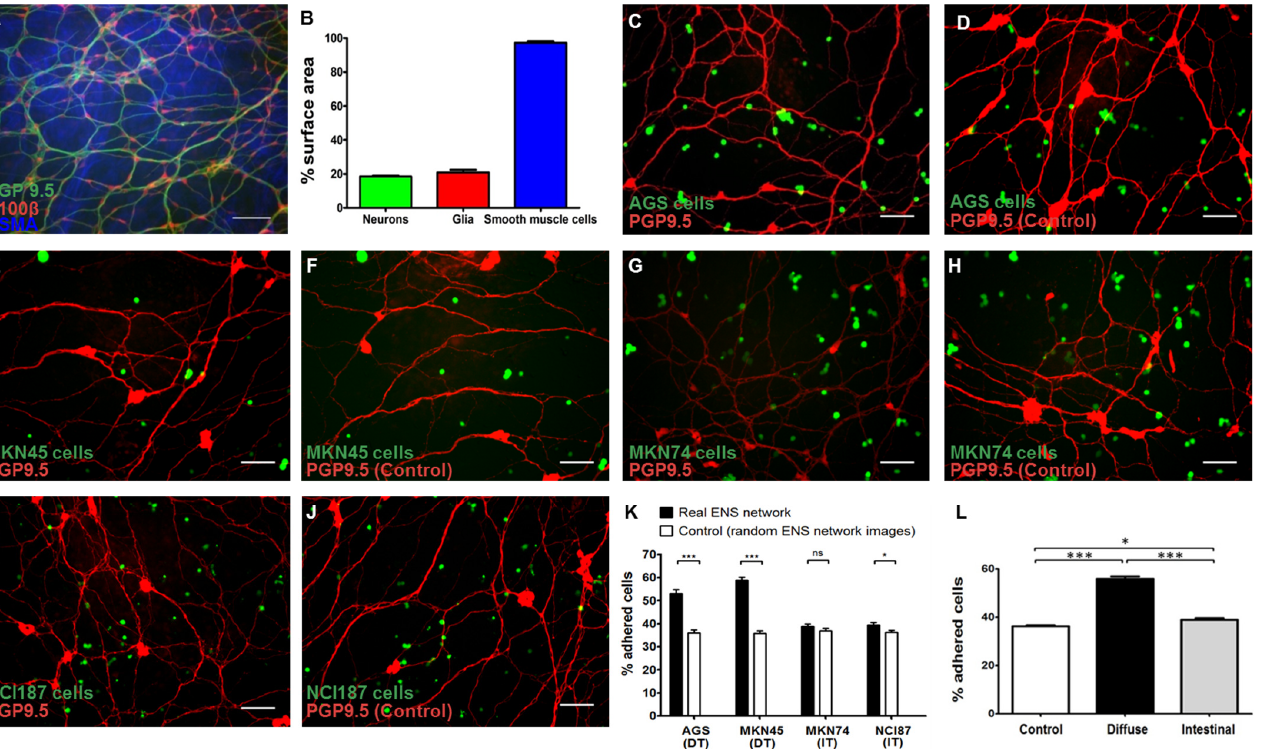
Figure 1. Characterization of the primary culture of gastric enteric nervous system (pcgENS) and adhesion of the GC cells to the enteric nervous structures of the pcgENS. ( A ) Immunostaining of pcgENS on day 11. Staining of pcgENS cellular components using antibodies against PGP9.5 (green), S-100 β (red), and α -SMA (blue), illustrating the organization of neurons, glial cells, and smooth muscle cells, respectively. Scale bar: 100 µ m. ( B ) Quantification of the area covered by each cellular component present in the primary culture of gastric enteric nervous system (pcgENS): neurons, glial cells (Glia), smooth muscle cells. Data are expressed as mean ± SEM of the percentages relative to the total area of the well ( n = 10 wells). ( C – J ) Enteric neurons (red/PGP9.5) after 1-h incubation with GFP-positive AGS, MKN45, MKN74, and NCI187 cells (green) ( C , E , G , I , respectively) and the control images merging the corresponding GC cell signal (green) with the enteric neuron signal (red/PGP9.5) from a randomly chosen image ( D , F , H , J respectively). Scale bar: 100 µ m. ( K ) Comparison of the percentage of adhered cells to the percentage of cells which could potentially adhere to a random ENS network image for each cell line ( n = 19 wells per cell line; ns = non-significant; * p < 0.05; *** p < 0.001; Mann–Whitney test). ( L ) Comparison of the percentage of adhered cells to neurons between the two types of GC cells ( n = 38 wells per type). A significantly higher adhesion rate is observed for diffuse-type GC cells (AGS and MKN45 cell lines) compared to the intestinal-type cells (MKN74 and NCI187 cell lines) (* p < 0.05; *** p < 0.001; one-way parametric ANOVA).